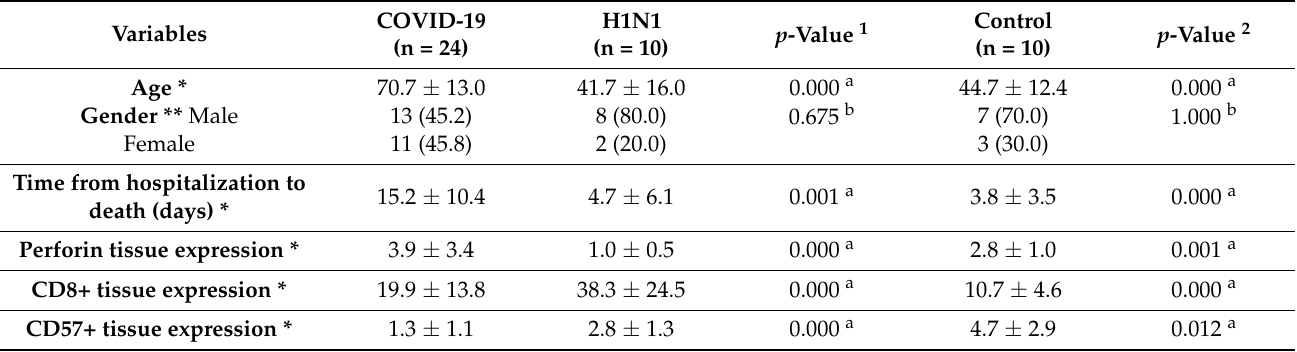
Table 1. Baseline characteristics in the study